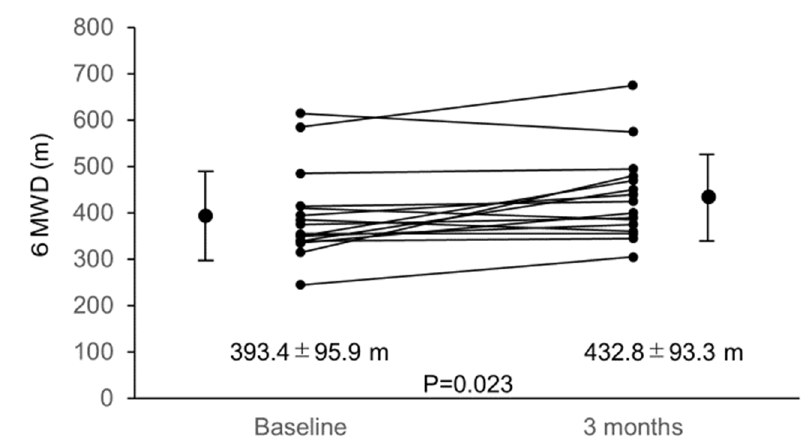
Figure 3. Changes in 6MWD from baseline to 3 months. 6MWD increased significantly from baseline to 3 months after starting astaxanthin supplementation. Abbreviations: 6MWD, 6-min walk